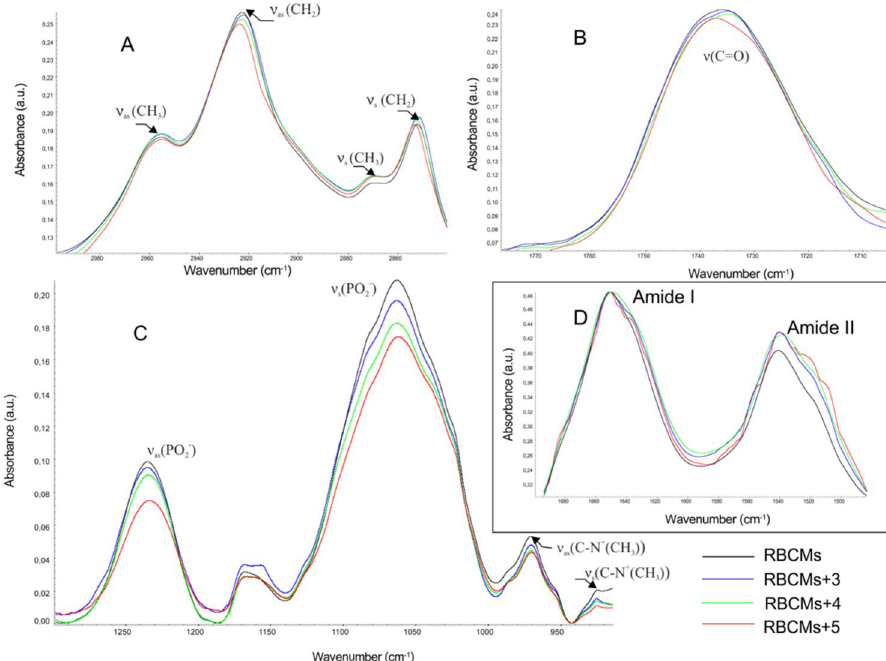
Figure 3. FTIR spectra of RBCMs and of RBCMs modified with flavonoids, concentration of compounds 50 µM; ( A ) C–H stretching regions, ( B ) carbonyl band, ( C ) phosphate and choline band of lipids, ( D ) amide